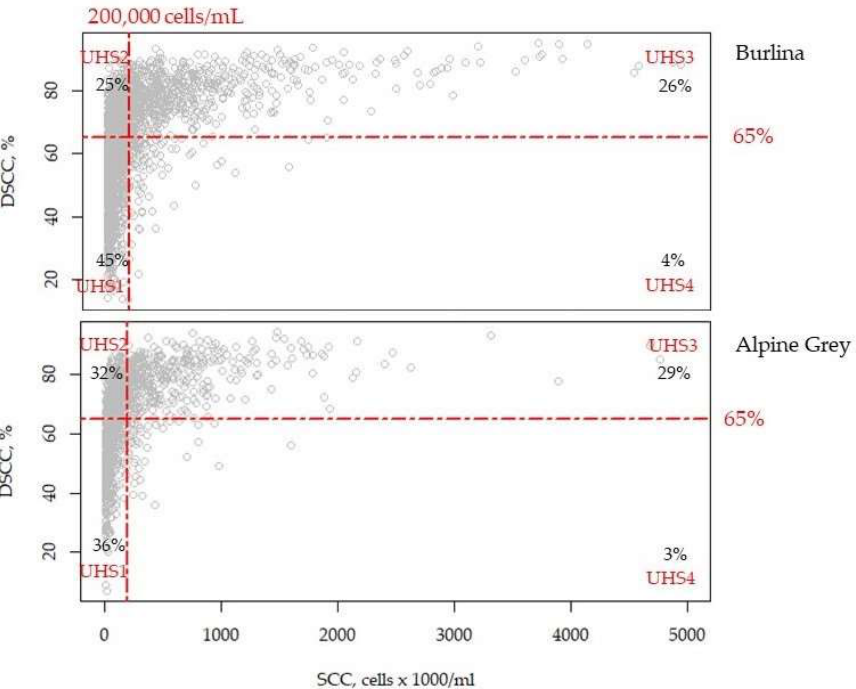
Figure 1. Distribution of milk test-day records across the four udder-health status (UHS) groups identified in the two breeds by mean of specific cut-offs (in red). The amount (%) of milk test-day records is reported in each quadrant (in black). Records were classified according to somatic cell count (SCC) and differential somatic cell count (DSCC, combined proportion of polymorphonuclear neutrophils and lymphocytes out of the total SCC) as follows: UHS1 if SCC ≤ 200,000 cell/mL and DSCC ≤ 65%, UHS2 if SCC ≤ 200,000 cell/mL and DSCC > 65%, UHS3 if SCC > 200,000 cell/mL and DSCC > 65%, and UHS4 if SCC > 200,000 cell/mL and DSCC ≤ 65%.